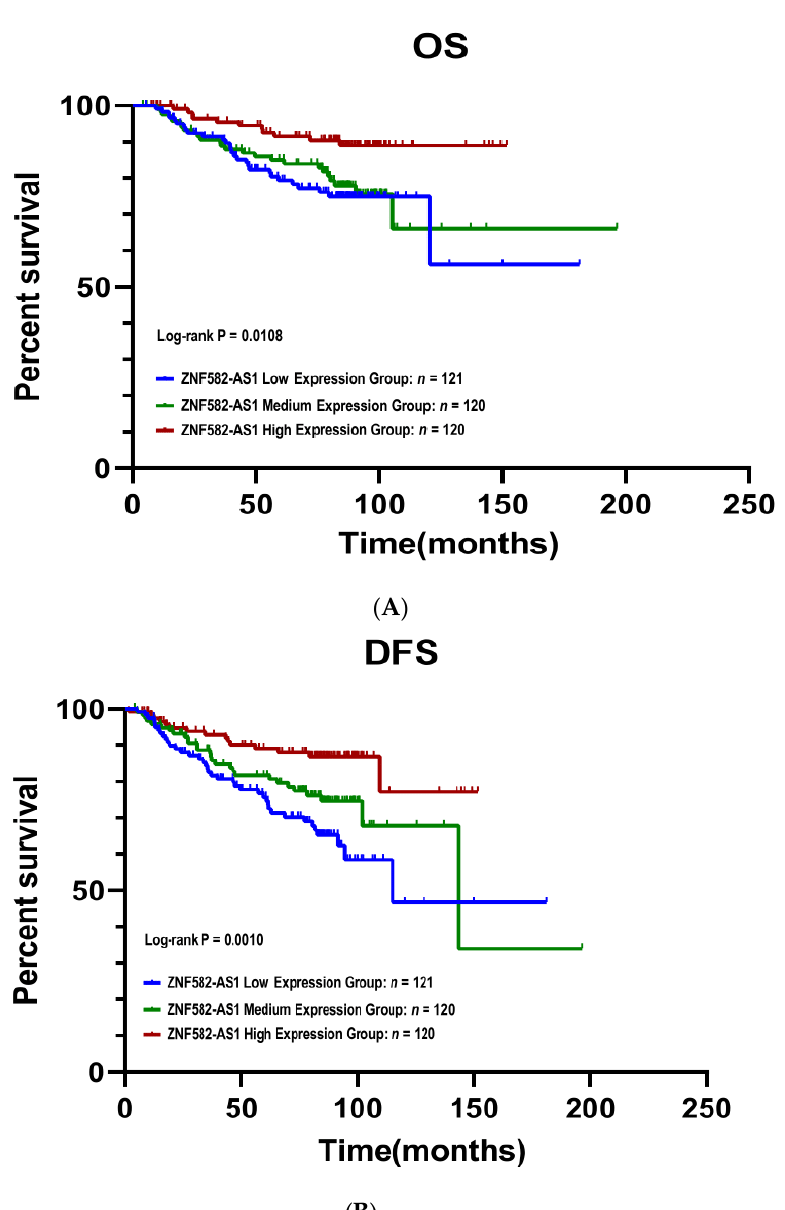
Figure 2. Kaplan–Meier survival curves by ZNF582-AS1 expression in tertile. ( A ) Overall survival